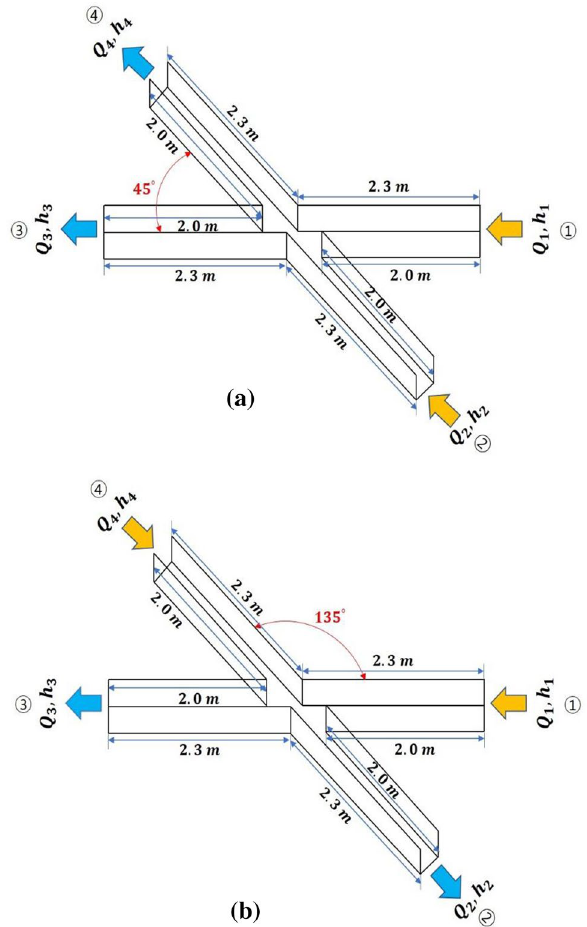
Fig. 5 Experimental conditions: a Case I and b Case II